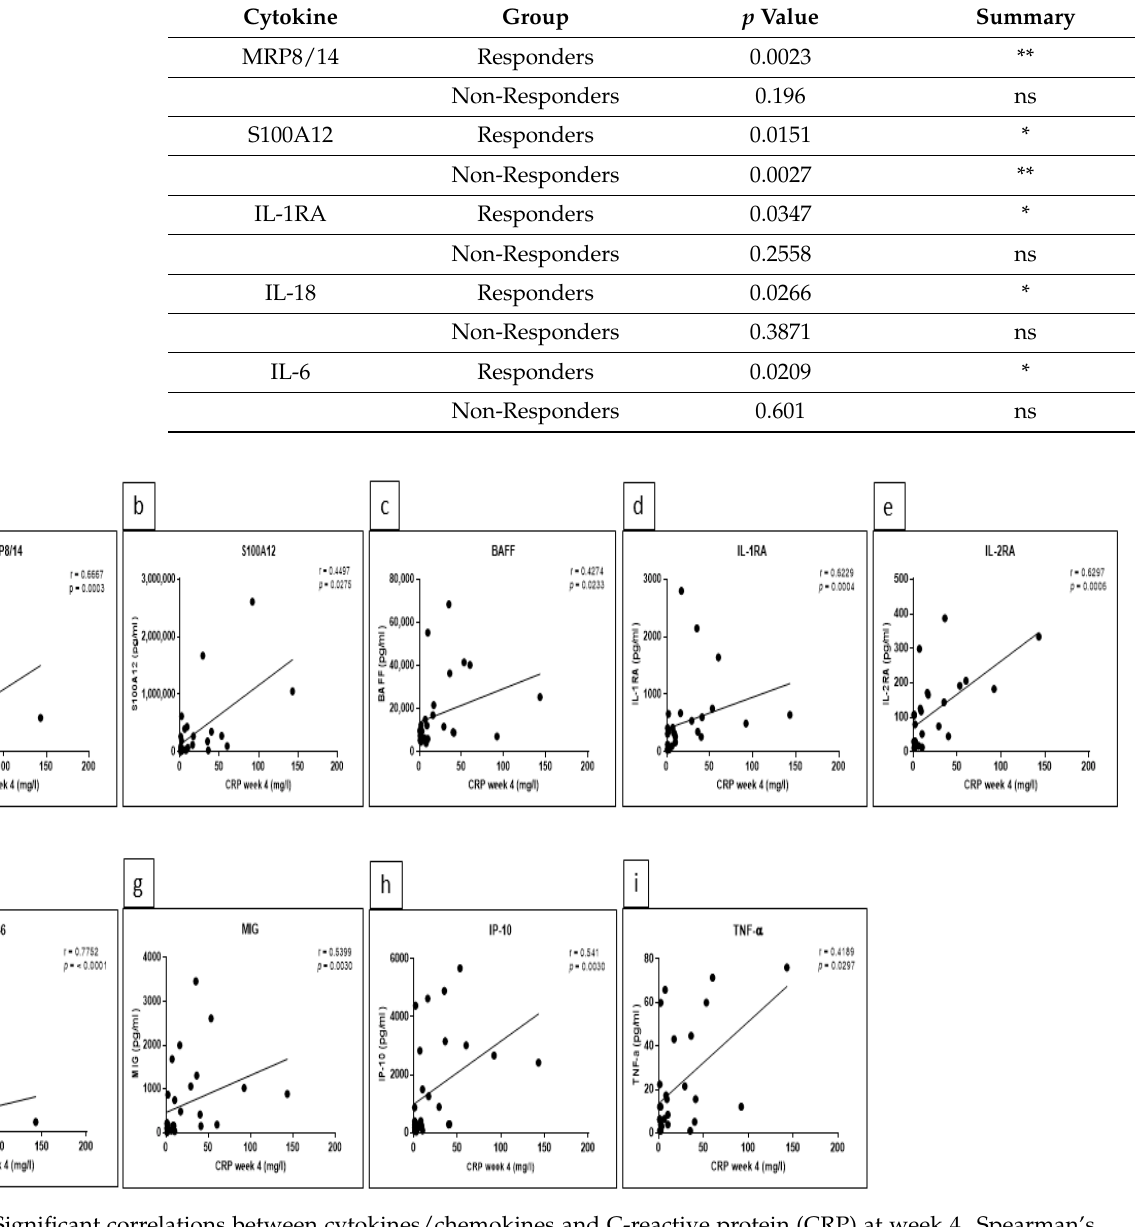
Figure 5. Significant correlations between cytokines/chemokines and C-reactive protein (CRP) at week 4. Spearman’s correlation coefficient r and p values of correlation analyses between CRP and MRP8/14 ( a ), S100A12 ( b ), BAFF ( c ), IL-1RA ( d ), IL-2RA ( e ), IL-6 ( f ), MIG ( g ), IP-10 ( h ), and TNF- α ( i ) in all patients. GraphPad Prism 7 was used and statistical significance was set at p < 0.05.